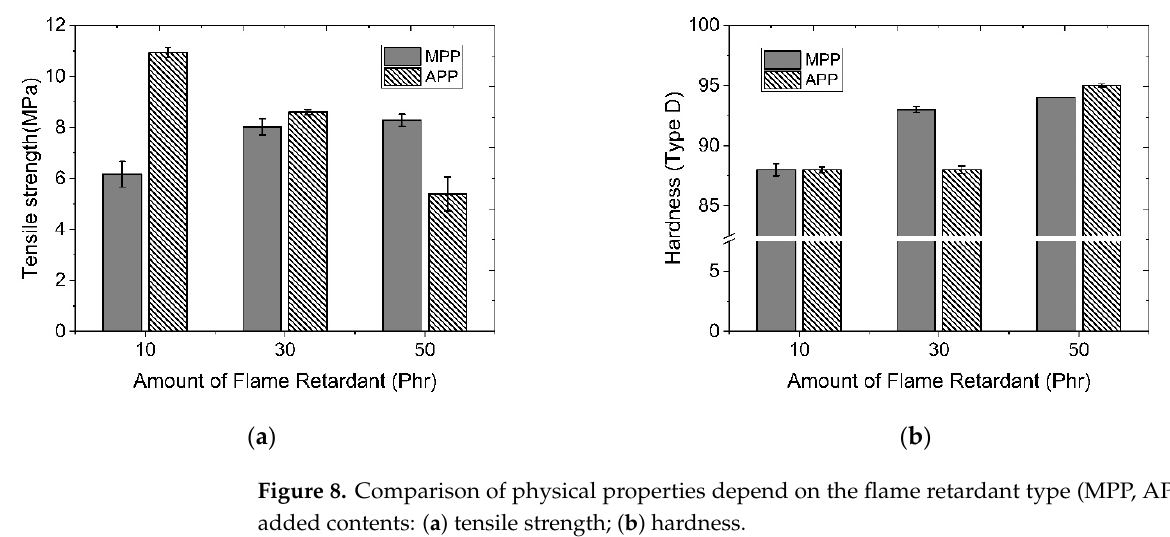
Figure 8. Comparison of physical properties depend on the flame retardant type (MPP, APP) and added contents: ( a ) tensile strength; ( b ) hardness.